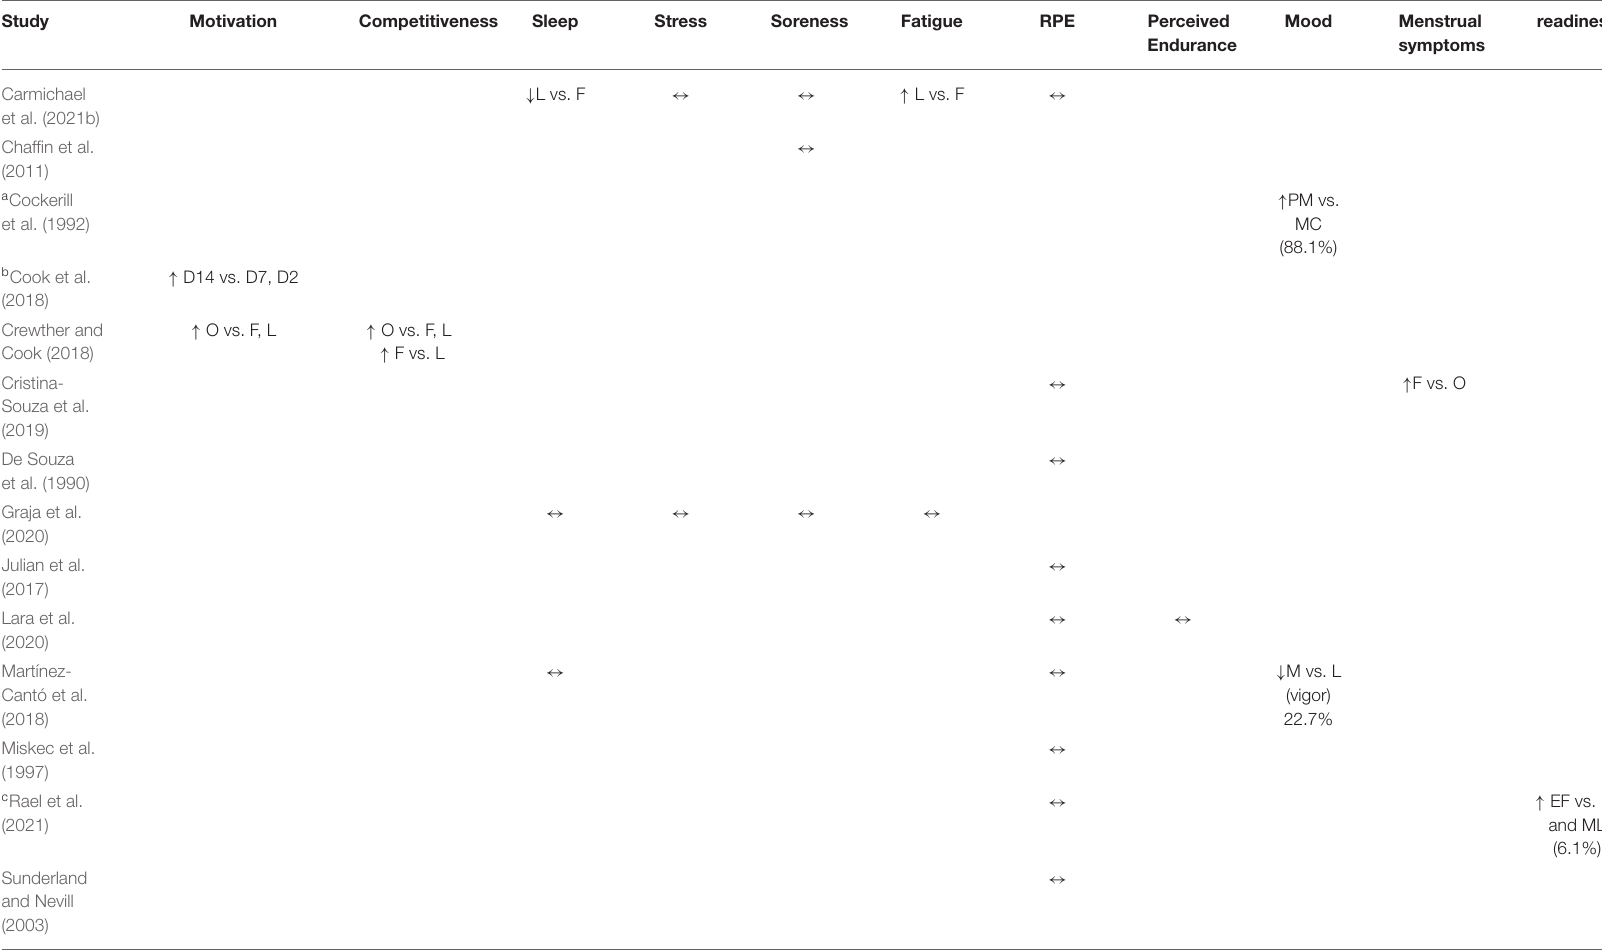
TABLE 2 | Perceptual measure and main outcomes. Study Motivation Competitiveness Sleep Stress Soreness Fatigue RPE Perceived